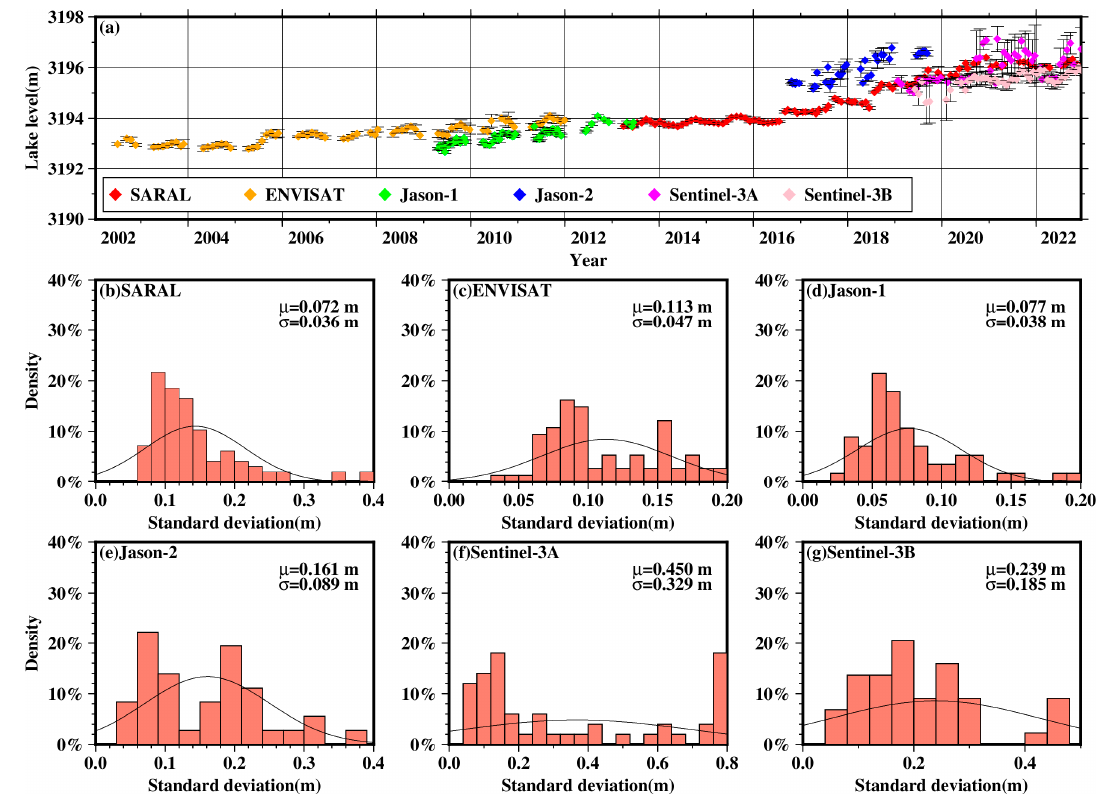
Figure 6. ( a ) The averaged Lake water level per cycle measured by satellites; ( b – g ) histogram distribution of standard deviation of lake water level for the SARAL, Envisat RA-2, Jason-1, Jason-2, Sentinel 3A SRAL, and Sentinel 3B SRAL satellites, respectively.